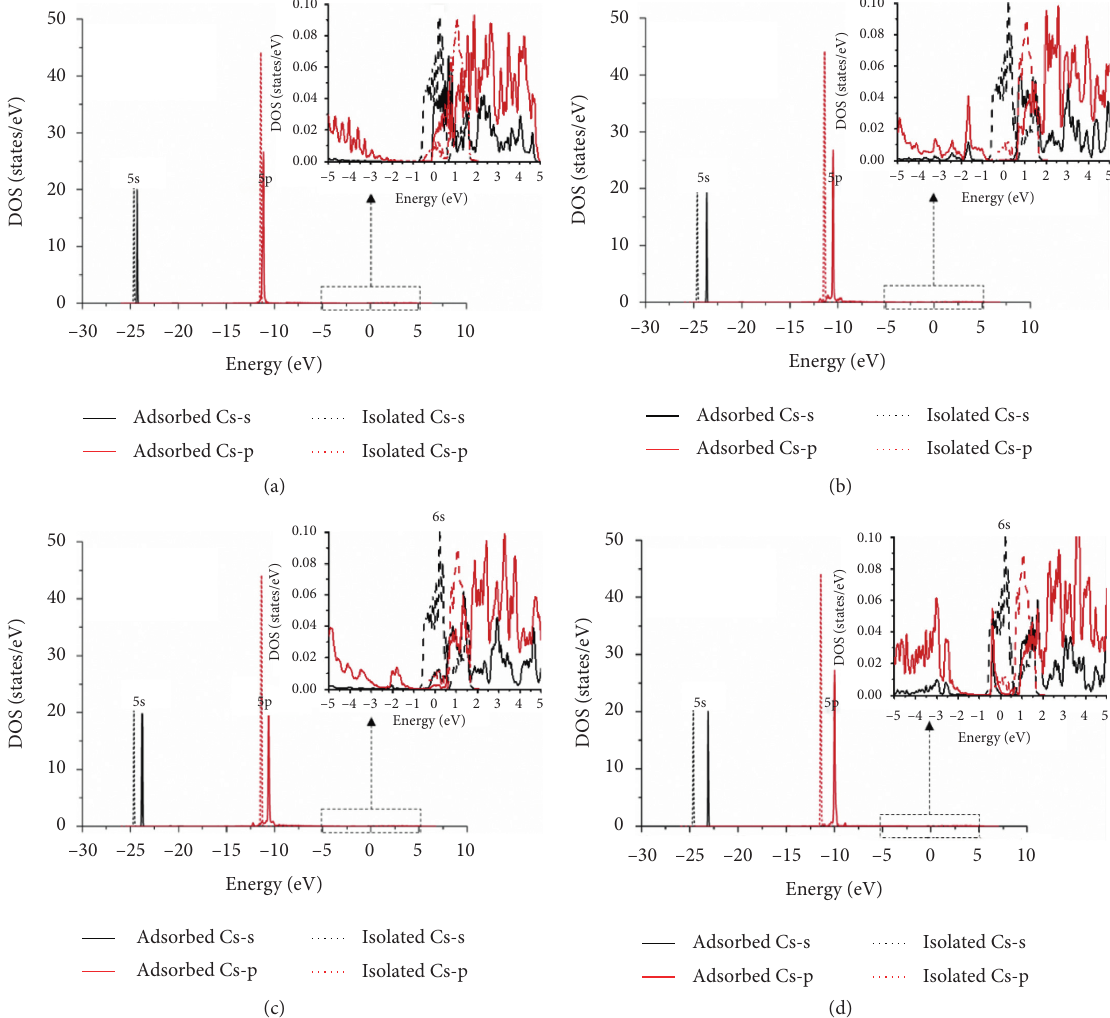
Figure 10: The DOSfor isolated Cs atom (dashed line) and Cs adsorbed on matrix graphite surface (solid line): (a) perfect matrix graphite surface; (b) “bridge” interstitial defect; (c) “spiro” interstitial defect; (d) single vacancy defect. The energy is relative to Fermi level ( E f ) at E �